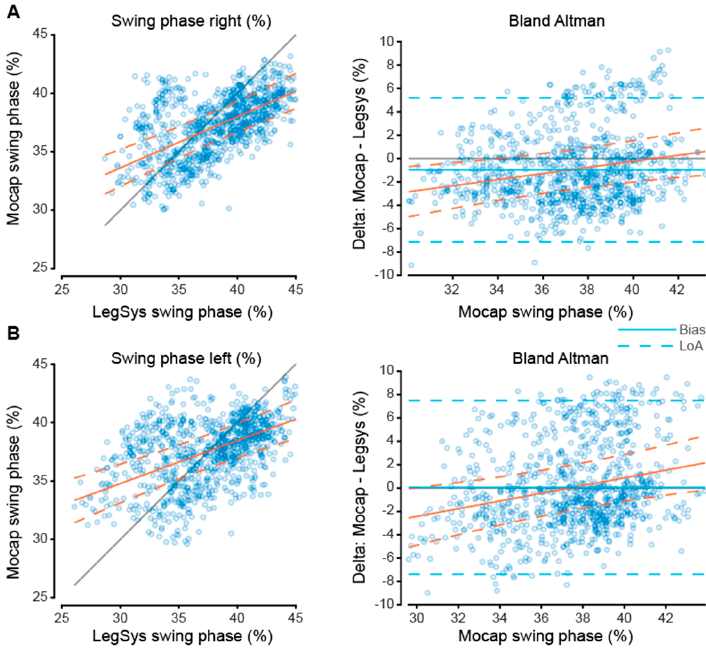
(%). Part A and B shows the scatter plot and bland-Altman plot on the left and right, respectfully for each parameter. For the scatter plot, the blue dots show right and left stance for each system. The bland-Altman plots show the difference between the MOCAP and LEGSYS parameters on the Y axis and MOCAP right and left stance. Blue line and dotted blue line show the bias and limits of agree- ment respectfully. The orange line on all 4 plots shows the least squares regression lines with orange dots being the 95% confidence interval.